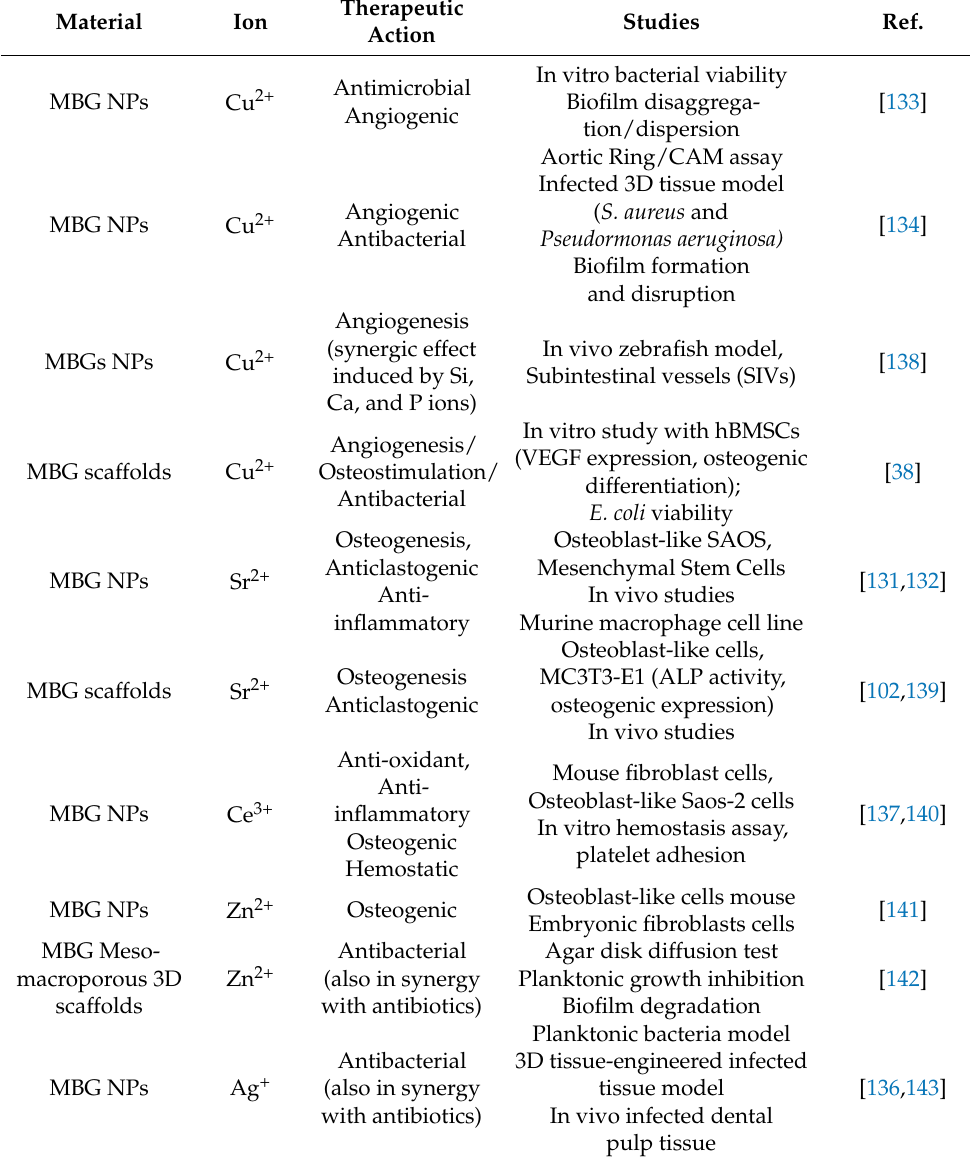
Table 1. Overview of selected MBG-based systems containing biologically active ions and their exerted therapeutic